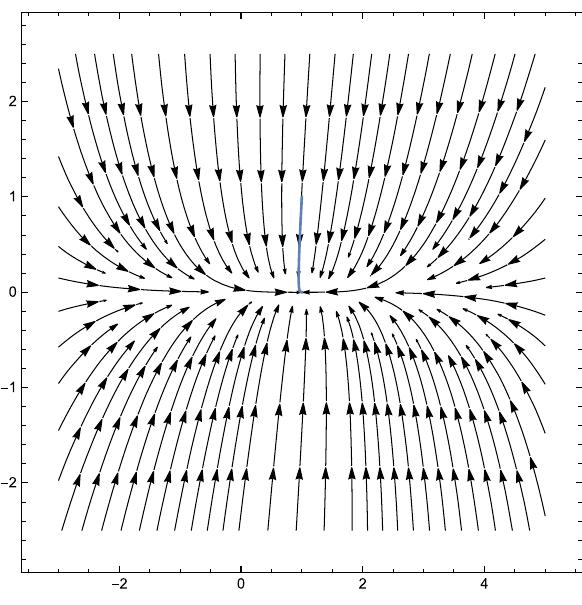
Fig. 1 The phase plot for F 1 at α 2 = 2 < 3, γ = 4